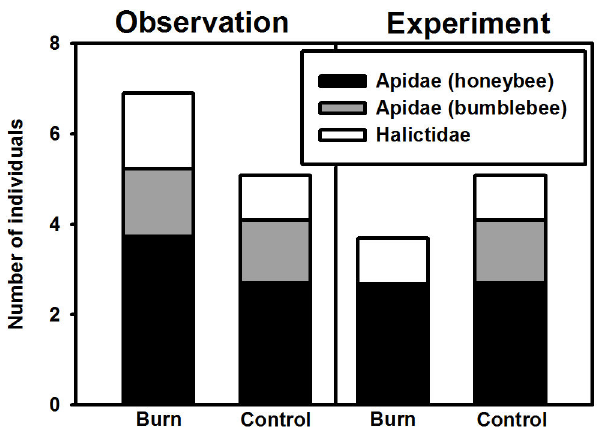
pollinator-specific visitation patterns. Means of individuals from the three most common pollinators are depicted for both the observational study and experimental manipulation. Note floral pollinator visitation to control plots is identically averages over the visitation